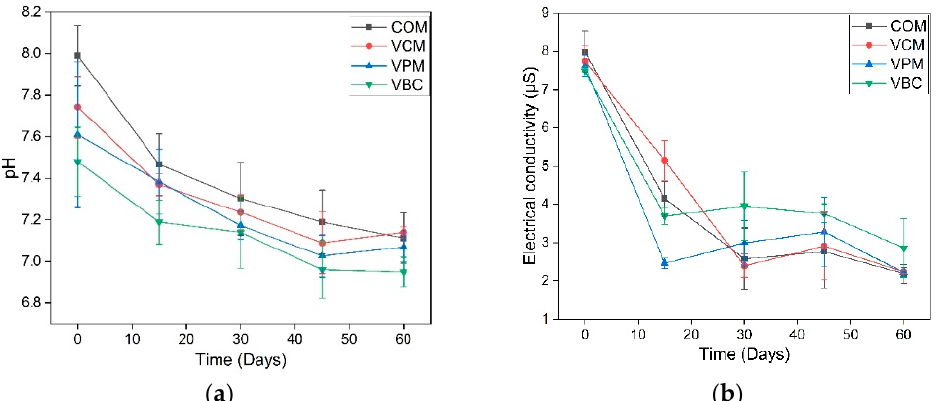
Figure 3. Temporal variations in ( a ) pH and ( b ) electrical conductivity during vermicomposting. Error bars represent standard errors ( n = 3).